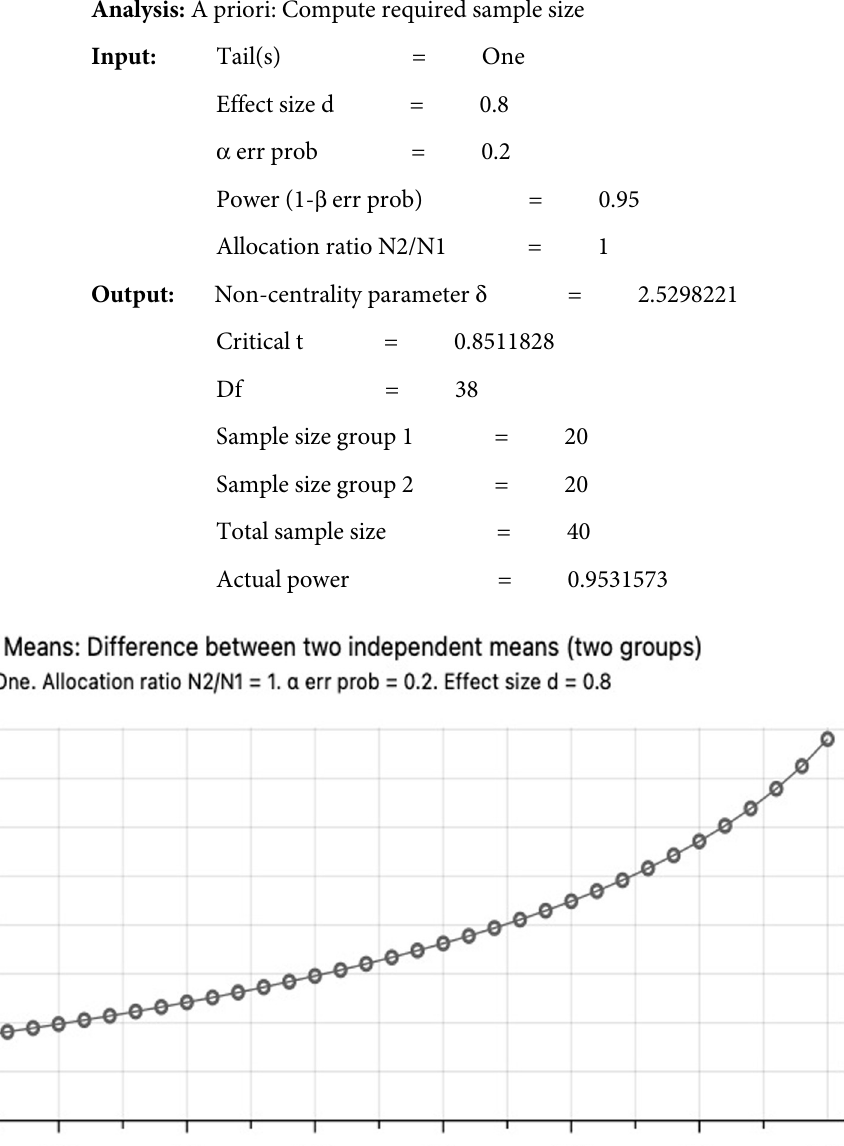
PLOS ONE | https://doi.org/10.1371/journal.pone.0267549 May 6,